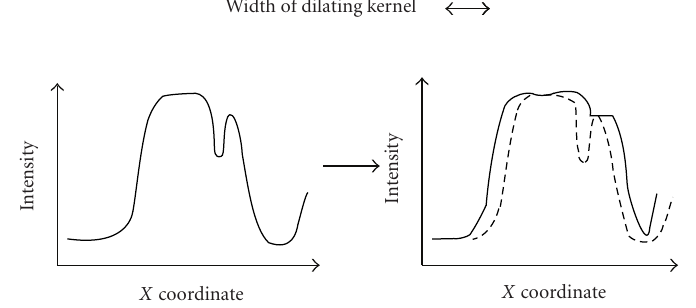
Figure 2.3. Grayscale dilation using a disc shaped structuring element. The graphs show a vertical cross section through a grayscale image. (Source: